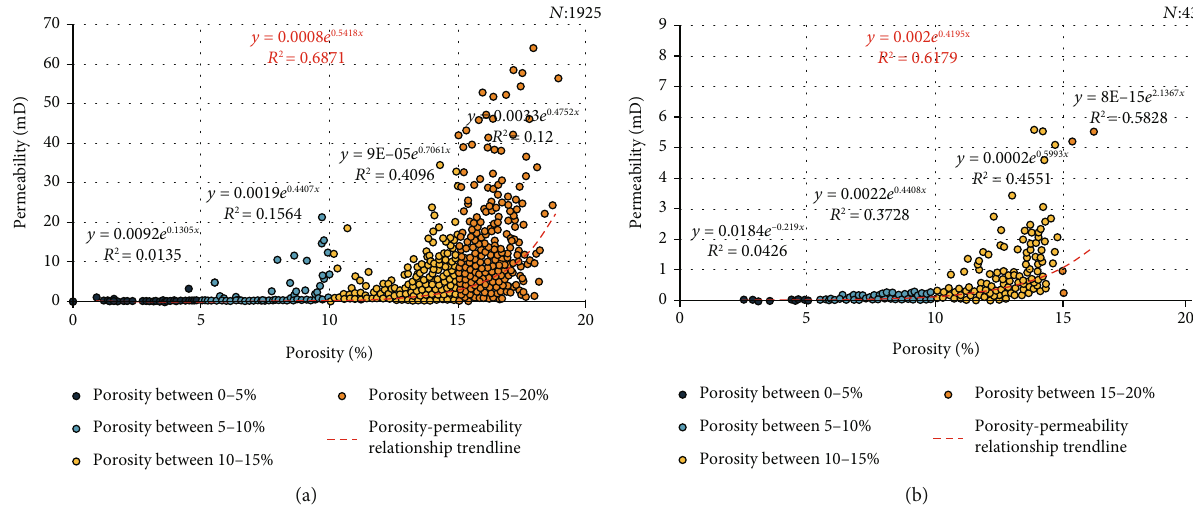
Figure 7: Di ff erence in the correlation between porosity and permeability in the Chang 8 between the porosity and permeability of the APA reservoir. (b) Correlation between the porosity and permeability of the YPA